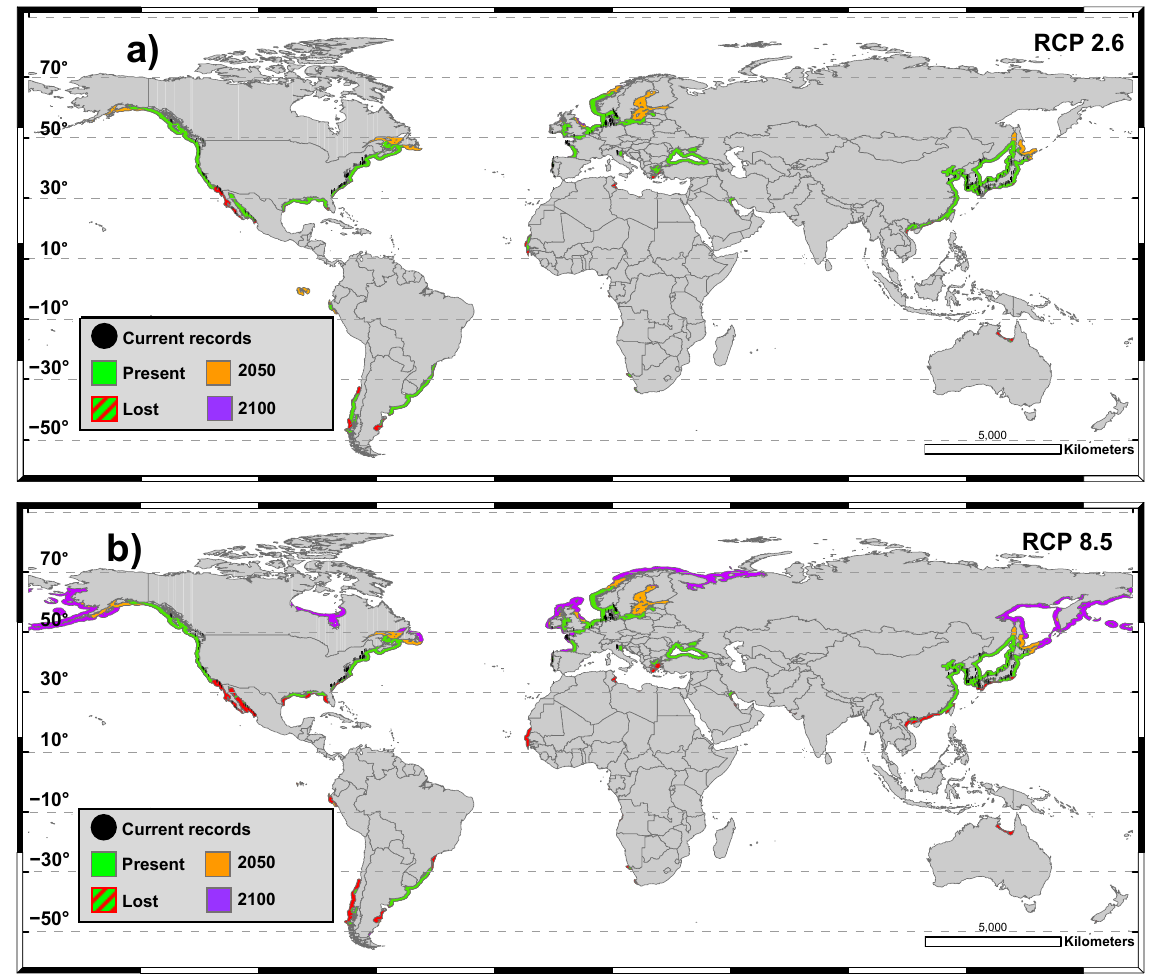
Figure 3. Maps of the potential habitat distribution based on temperature and salinity descriptor build for G. vermiculophylla under present conditions of temperature and salinity and under predicted future climate change scenarios (RCP 2.6 (Panel a ) and RCP 8.5 (Panel b )) by 2050 and 2100. Results were derived from the average of 25 simulations.